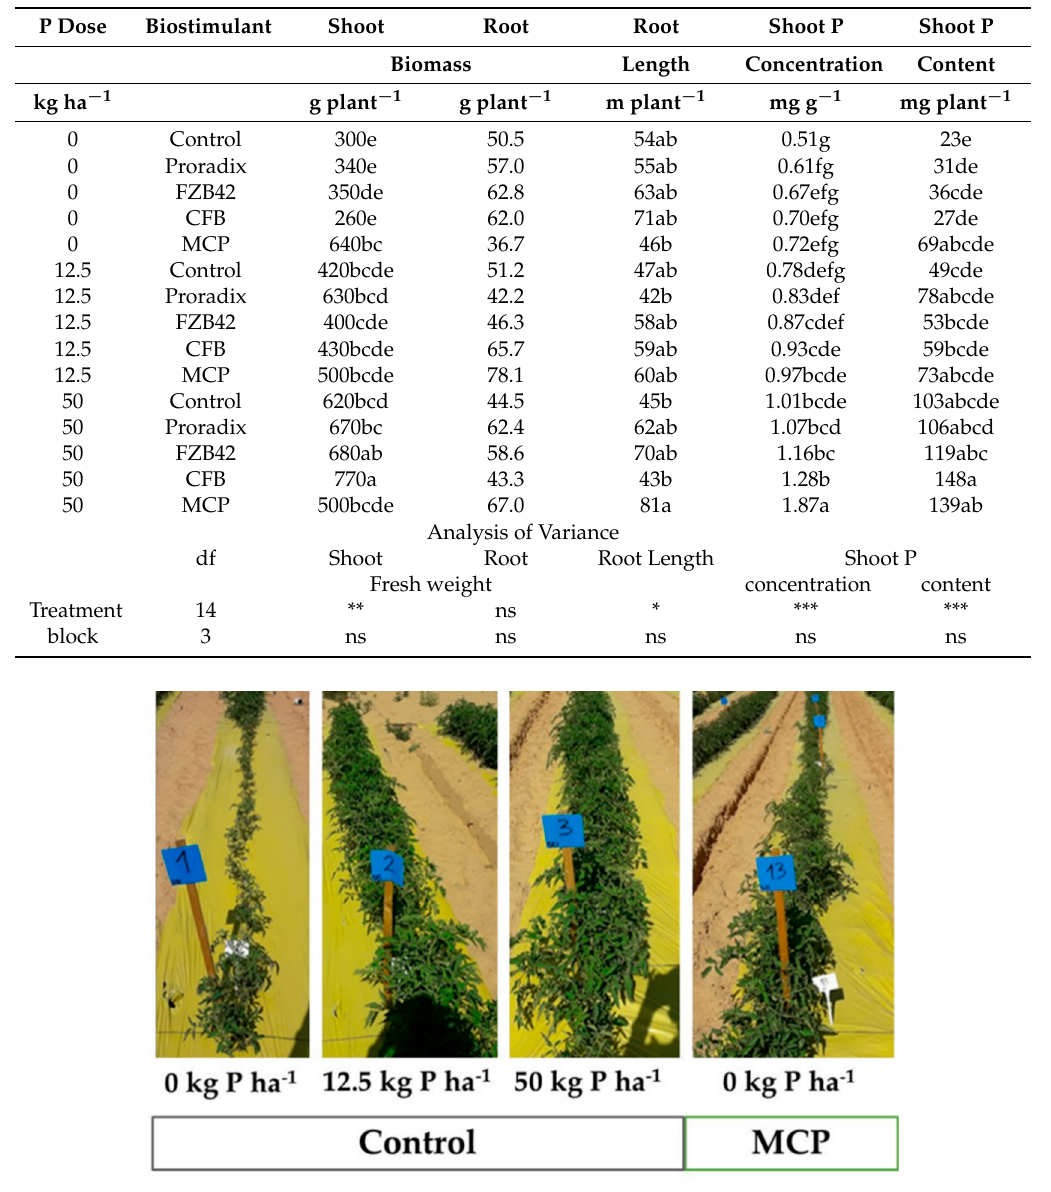
Figure 4. Effects of microbial consortia product (MCP) inoculation without external P fertilization on field performance of tomato plants at four months after sowing in comparison with different levels of P (triple superphosphate) fertilization in a field experiment at Ramat, Negev, Israel.